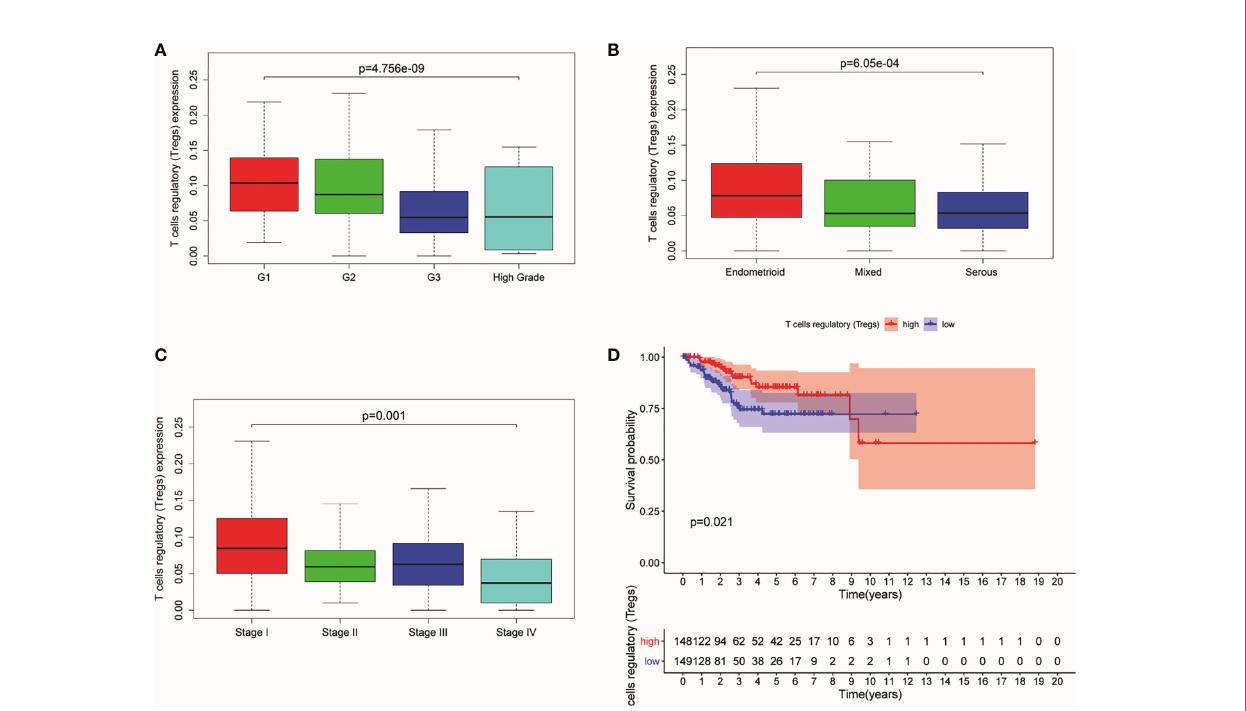
FIGURE 1 | Expression of Tregs in different stages and its relationship with survival probability. (A) Expression of Tregs in different pathological grades. (B) Expression of Tregs in different pathological morphology. (C) Expression of Tregs in different pathological EC stages. (D) Survival probability between patients with high and low T cells